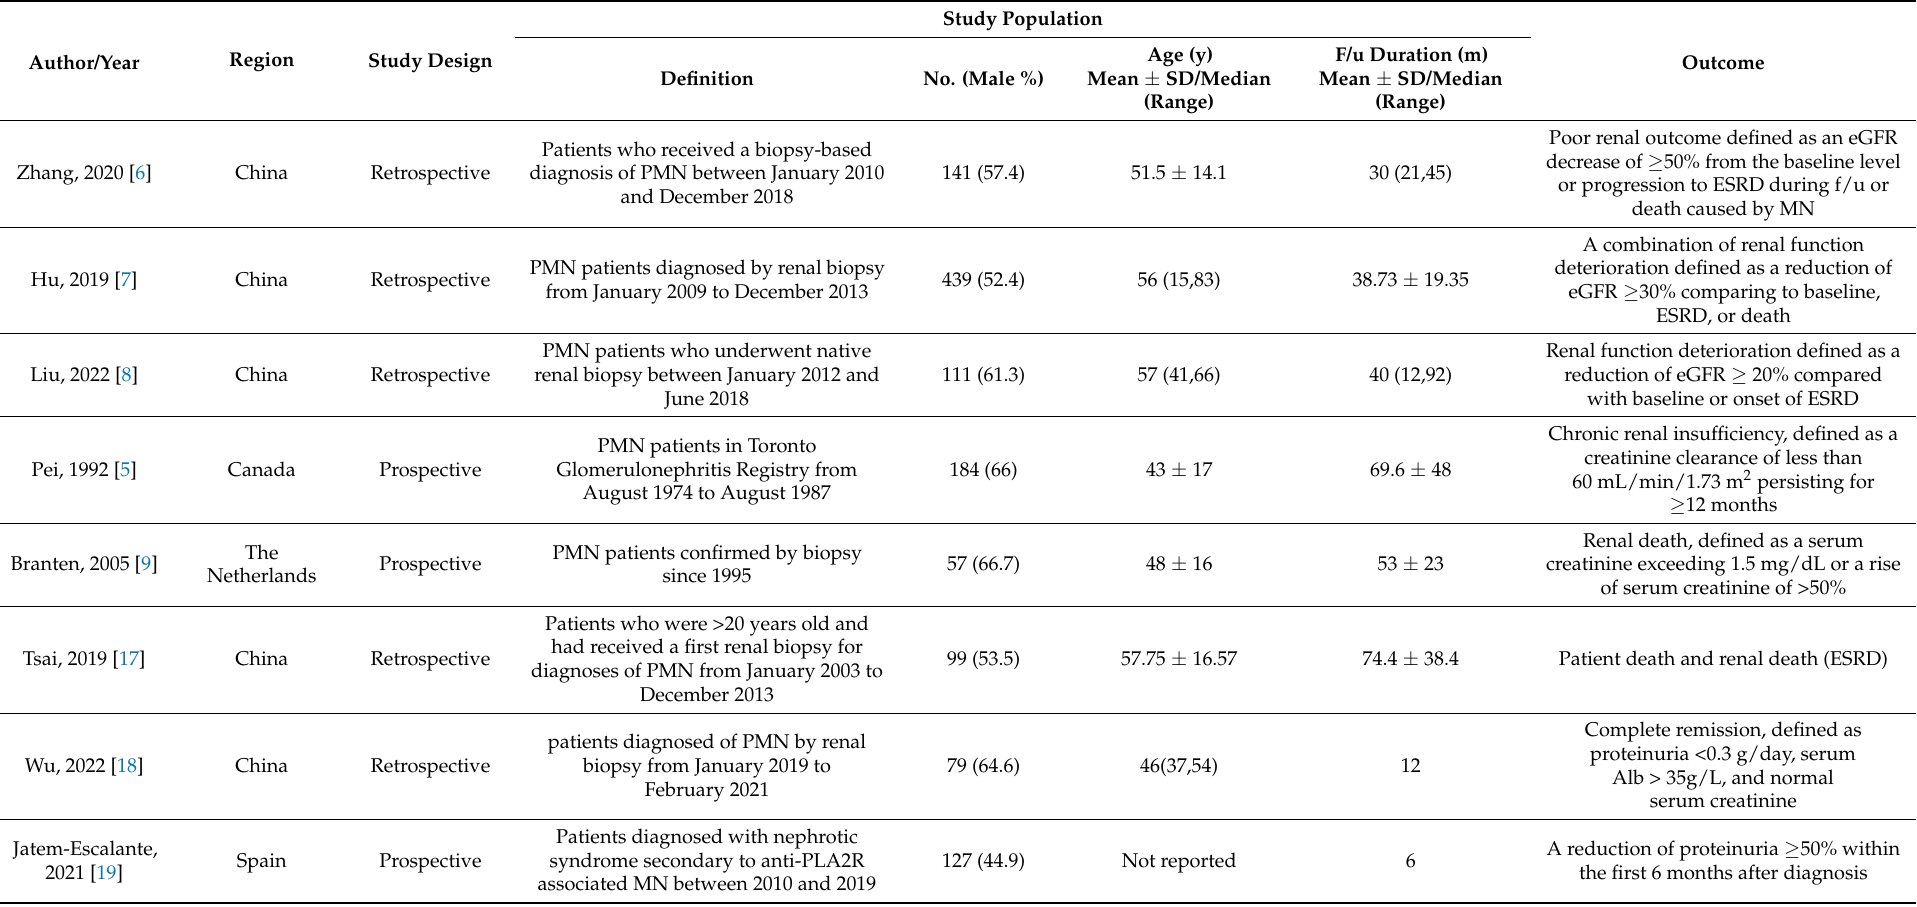
Table 1. Basic characteristics of included